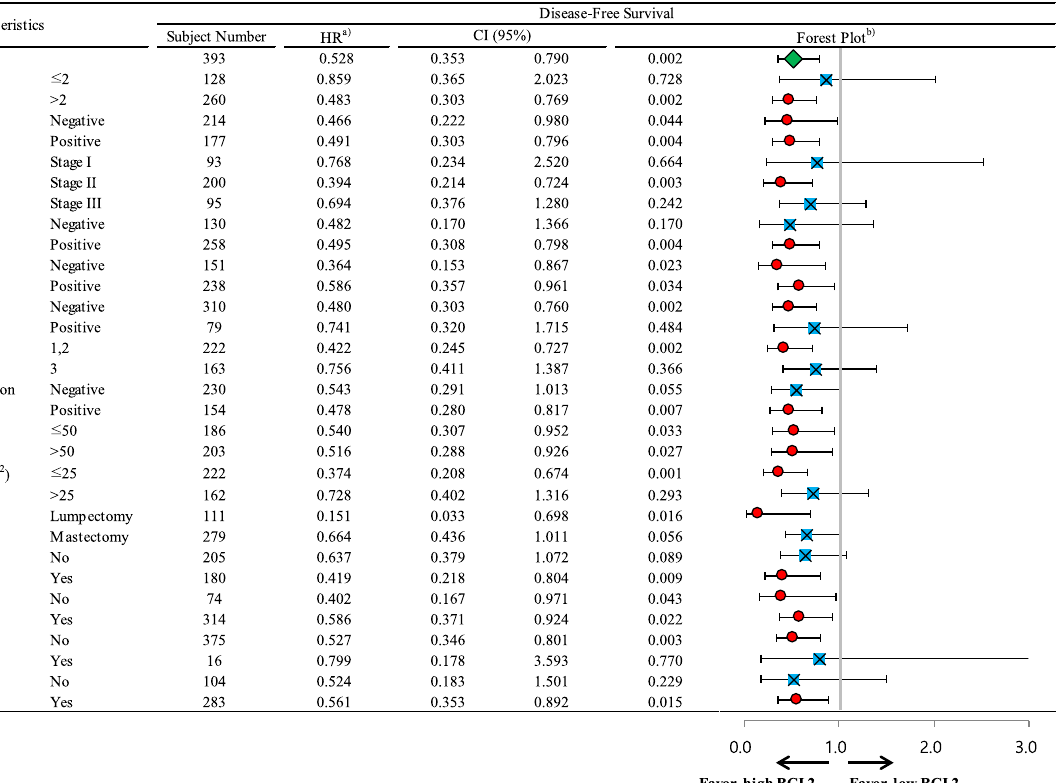
Figure 3. Subgroup analyses by Cox proportional hazards model according to BCL2 status regarding disease- free survival. Abbreviation: CI, confidence interval; HER2, human epidermal growth factor receptor 2; HR, hazard ratio. a) HRs are the relative risks of the high BCL2 group with reference of the low BCL2 group by Cox proportional hazards model. b) In the forest plot, a HR value of less than 1 favors the high BCL2 group against the low BCL2 group. The red circles mean statistical significance and the blue squares mean no statistical significance. The green diamond means the result of total